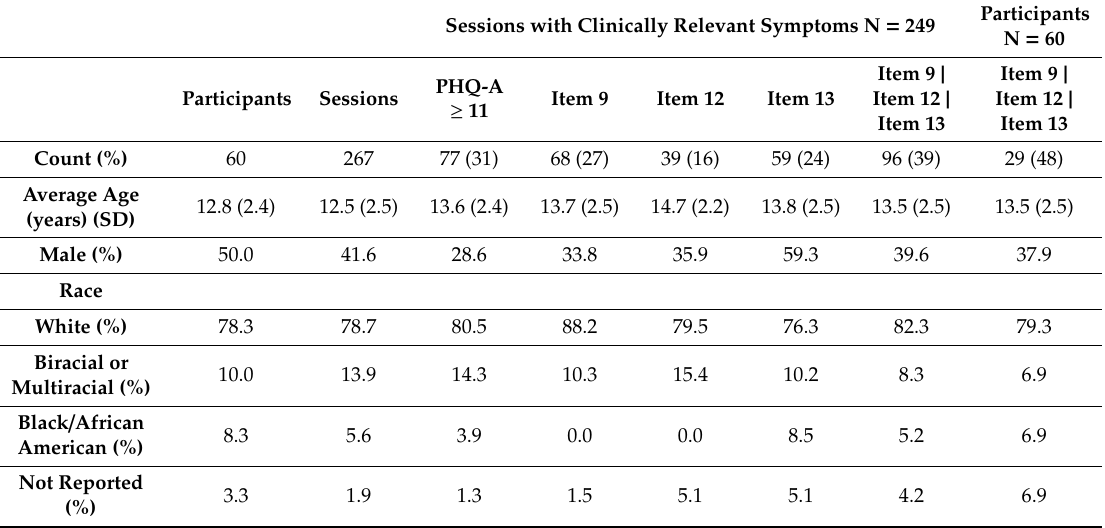
Table 3. Adolescent participant demographics and PHQ-A answer